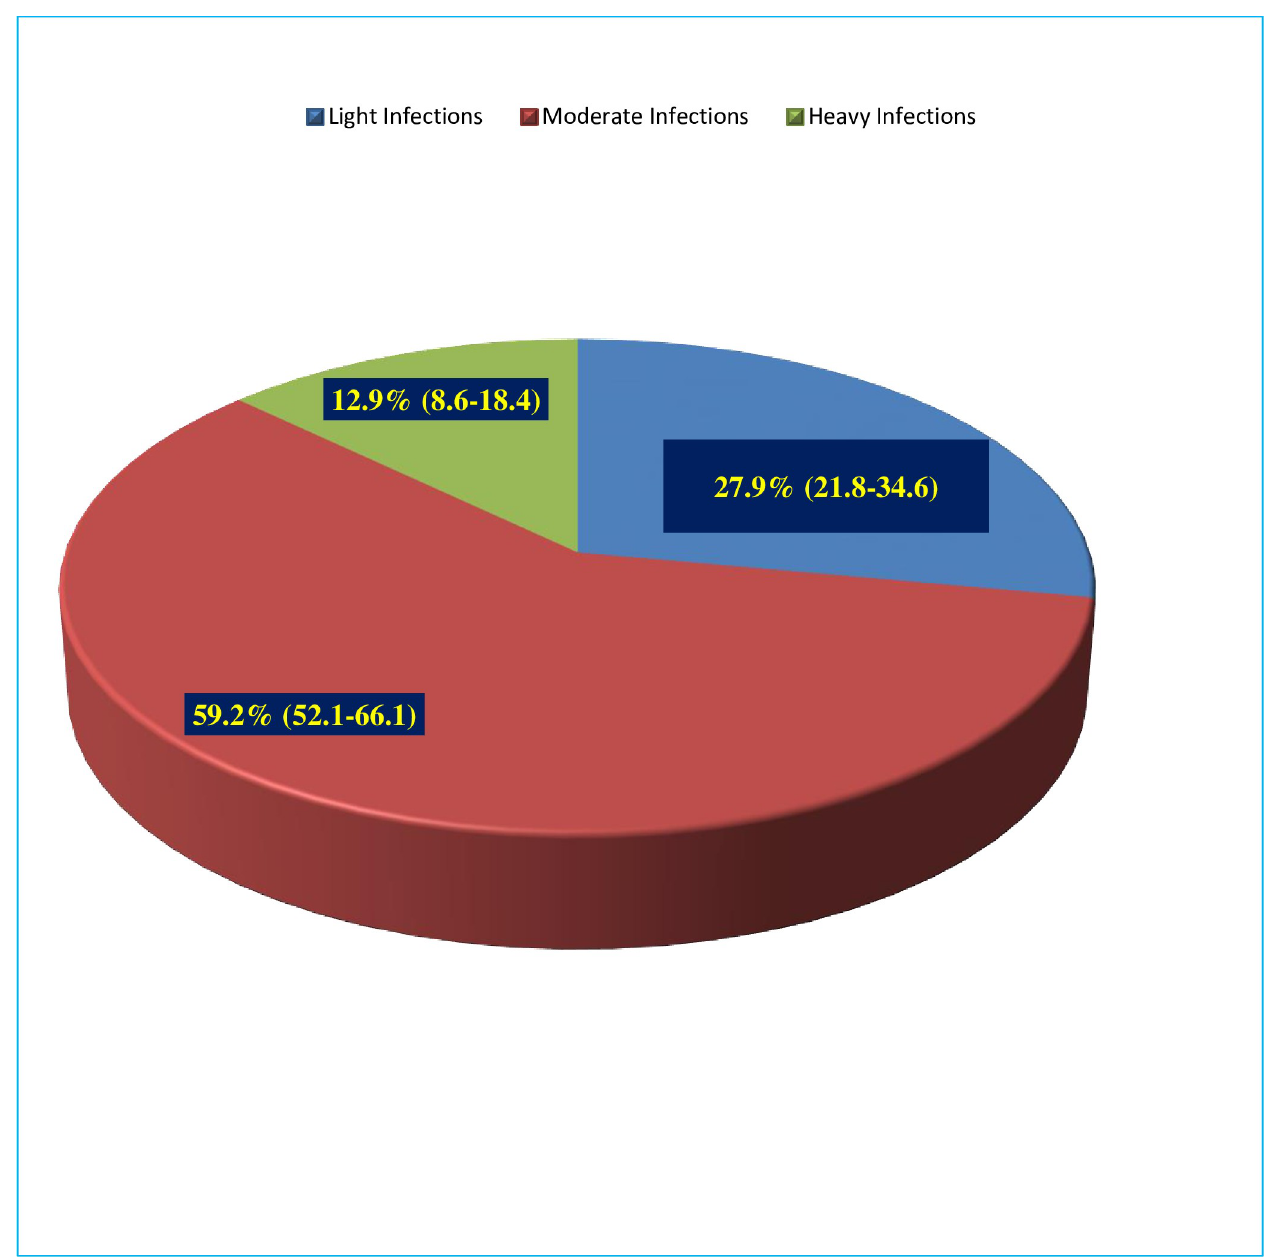
Fig 3. Intensity of S. mansoni